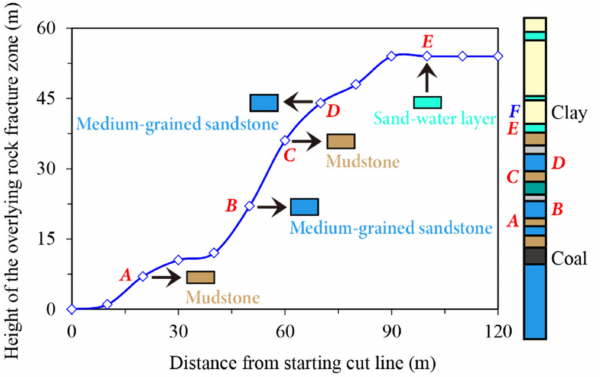
Figure 5. Height of failure zone of roof overburden fracture zone and corresponding triggered rock